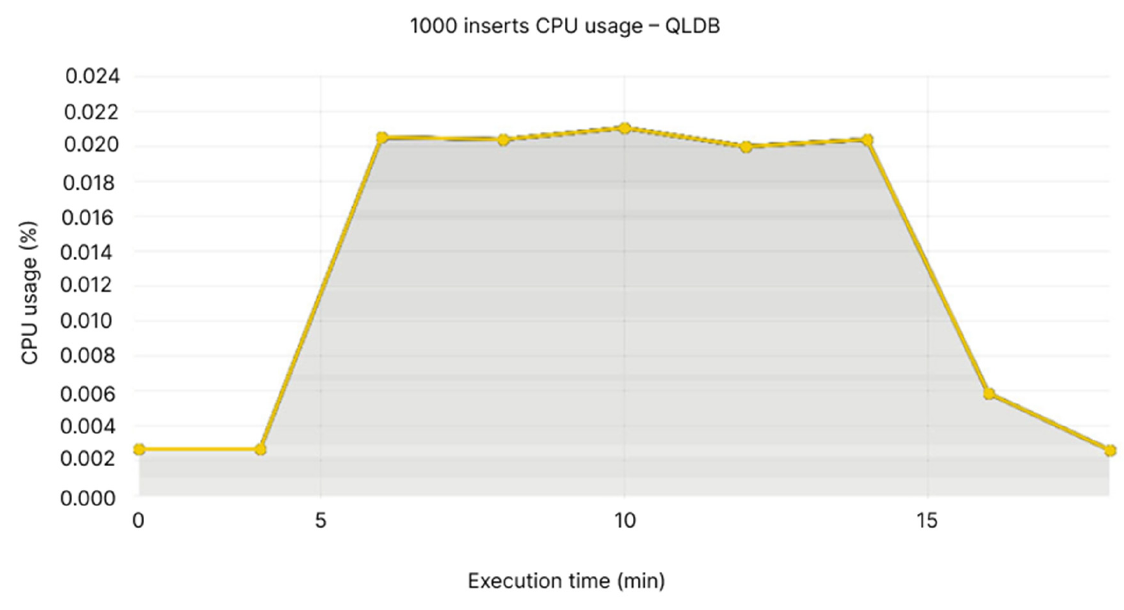
Figure 7. 1000 inserts CPU usage—QLDB.